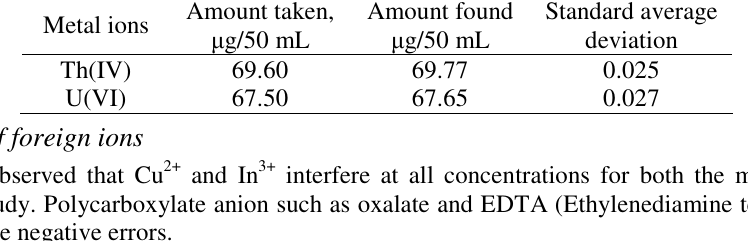
Table 3. Microdetermination of individual metal ions Metal